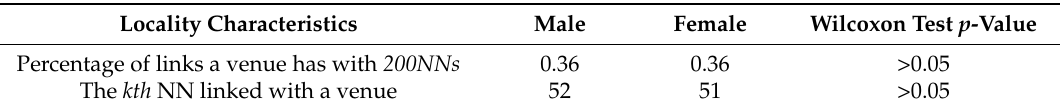
Table 1. Average values of the two locality characteristics for male and female users.